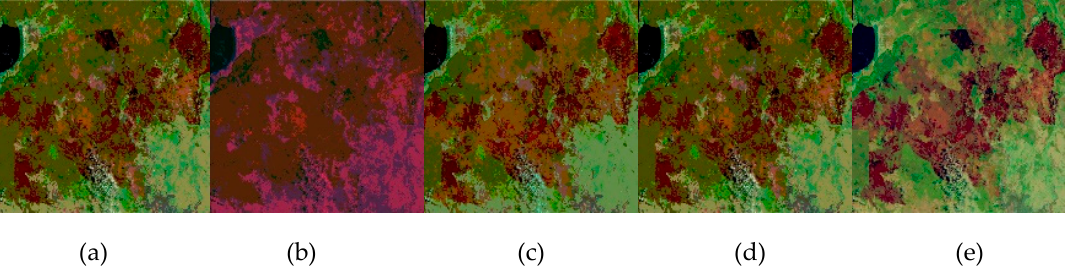
Figure 11. The segmented results of Satellite image4. ( a ) WOA; ( b ) FPA; ( c ) PSO; ( d ) BA; and ( e ) HSOA.